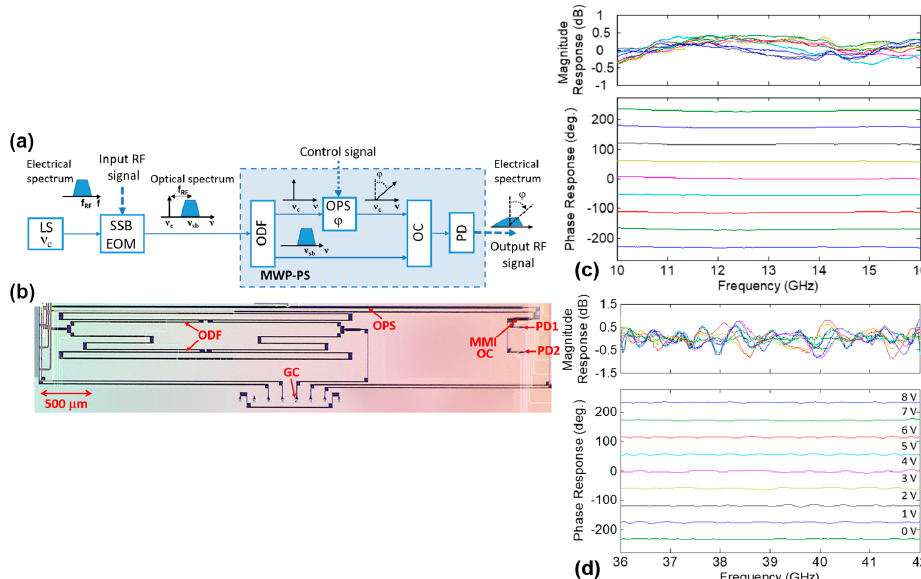
Figure 7. ( a ) Schematic and operation principle of the proposed photonic integrated phase shifter reported in [88]. LS: laser source; SSB EOM: single-sideband electro-optical modulator. In the scheme, f RF represents the RF signal carrier frequency, ν c the optical carrier frequency, ν sb is the central optical frequency of the optical SSB modulated signal, φ is the variable optical/RF phase shift. ( b ) Picture of the fabricated PIC; GC: grating coupler; MMI-OC: multi-mode interference optical coupler. Two PDs are connected to the two MMI